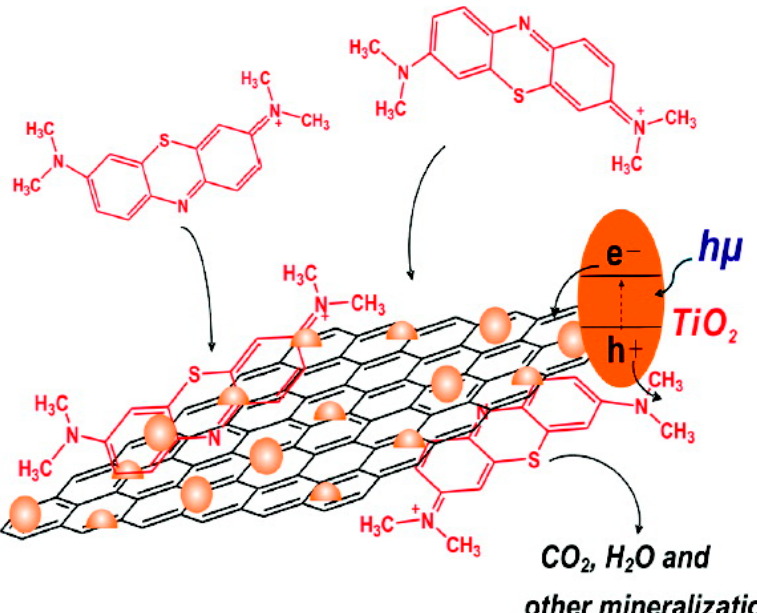
Figure 3. Improved photodegradation of methylene blue at the surface of TiO 2 /G nanocomposites. The improvement is due to a combination of enhanced MB adsorption due to dye-TiO 2 /G hydrophobic interactions and increased photogenerated electrons-positive holes lifetime. Reprinted with permission from reference [71]. Copyright 2010 American Chemical Society.